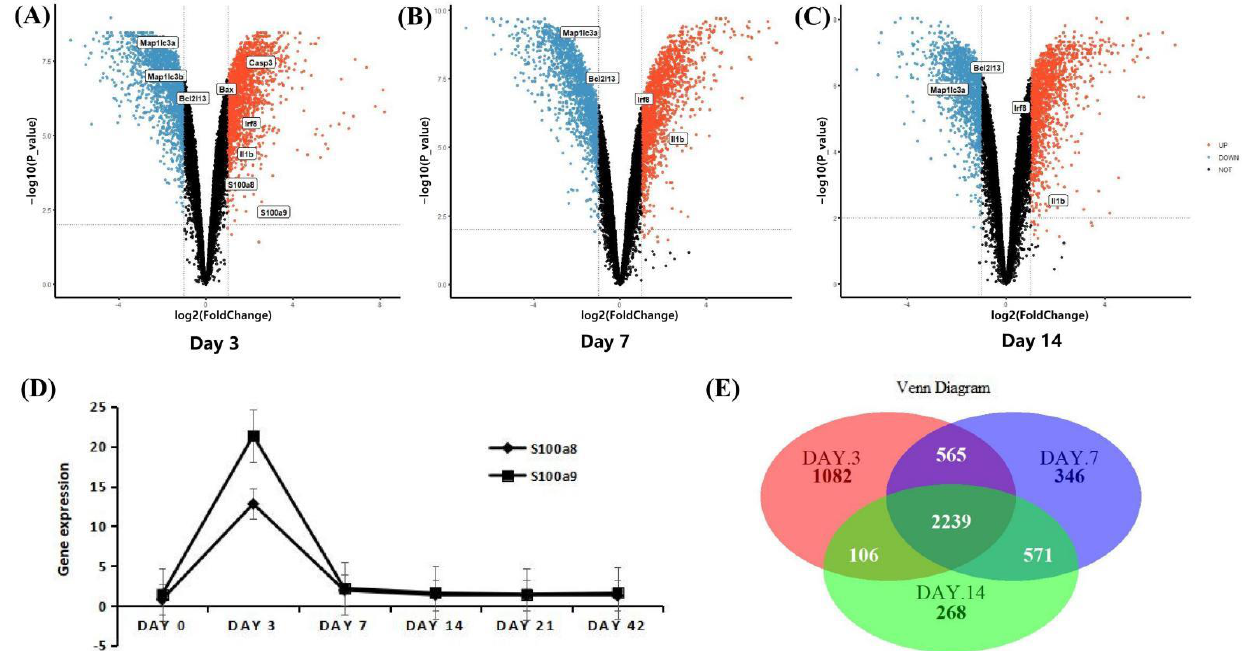
Figure 5. DEGs analysis of mRNA-seq data. ( A ) Volcano map of the difference in gene expression between injured and uninjured areas of the same heart on day 3 post-MI; and ( B ) for day 7 post-MI; ( C ) for day 14 post-MI. The filter conditions are the same as above: |log2 FC| > 1 and p < 0.05. ( D ) Line chart of S100a8 and S100a9 expression change after MI in the mRNA-seq data. ( E ) Venn diagrams of significant DEGs detected in injured vs. uninjured areas at 3, 7, and 14 days post-MI.